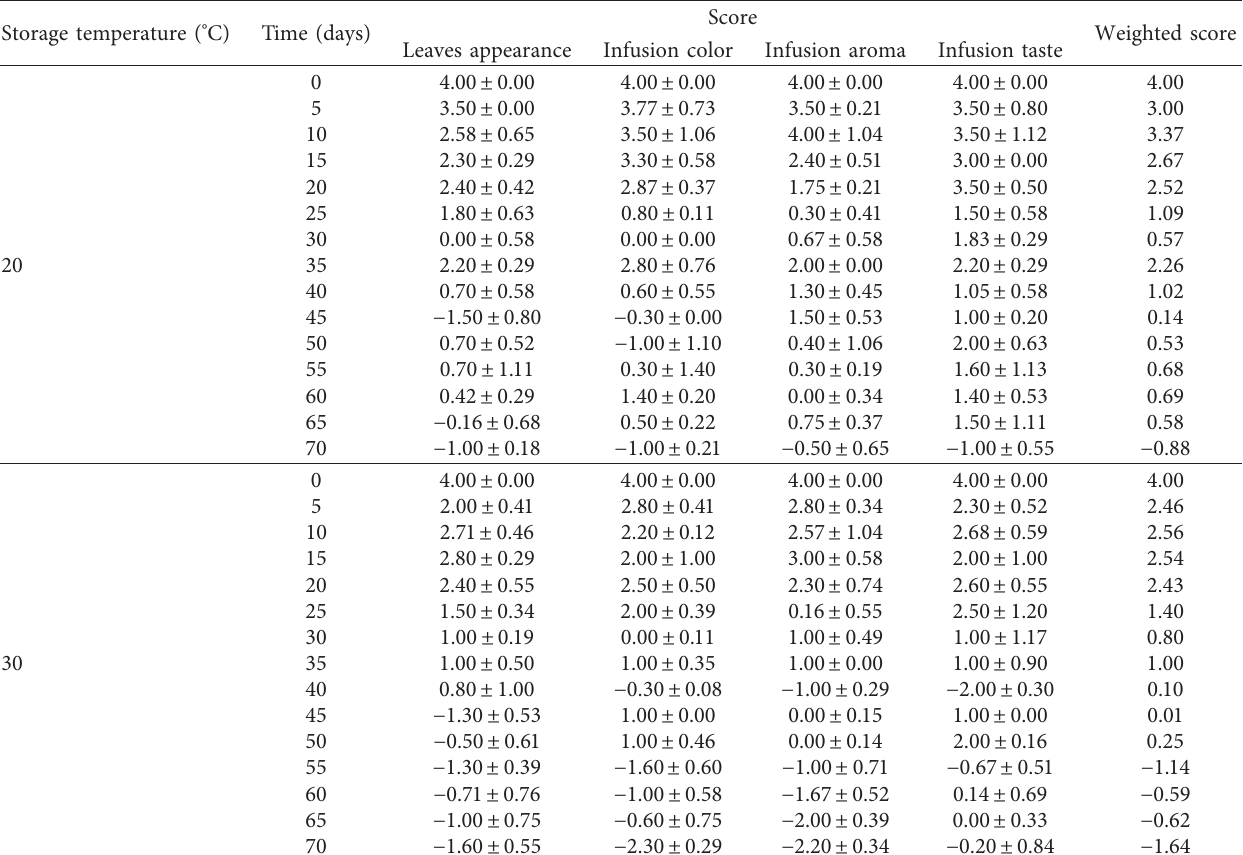
Table 3: Sensory attribute score and weighted score of tea samples under the ASLT (20 ° C, 30 ° C, and 40 °